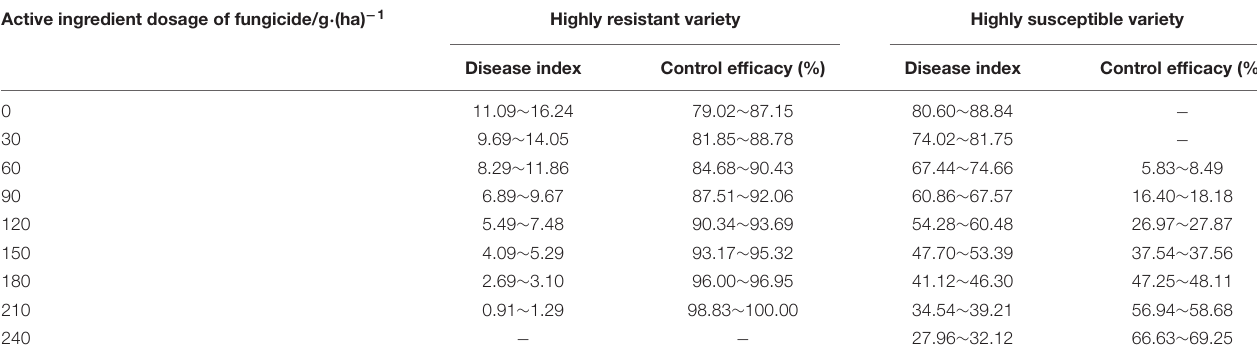
TABLE 11 | Reference table for the active ingredient dosages of triadimefon 20% EC to wheat powdery mildew on different resistant varieties. Active ingredient dosage of fungicide/g · (ha) −